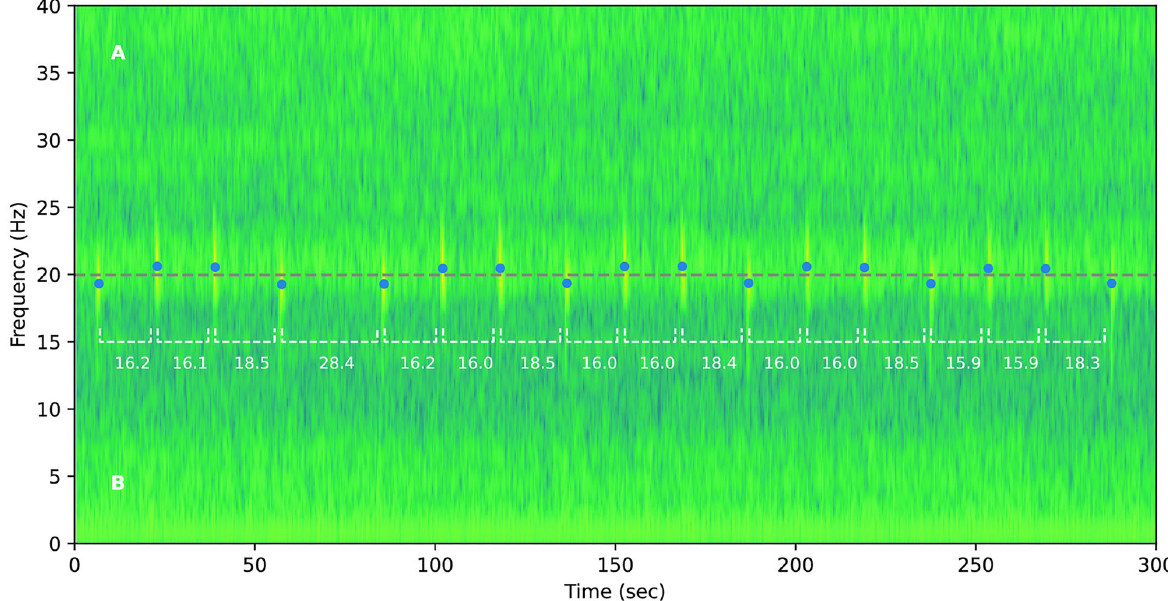
Figure 1. Spectrogram of a fin whale pulse sequence recorded by the Bombyx buoy in October 2018. Spectrogram parameters are described in section "Spectro-temporal pulse analysis". Dots show the center frequencies of the detected pulses, with white dashed lines showing the IPIs. The grey dashed line denotes the discrimination threshold between A and B pulse types, at 20 Hz.